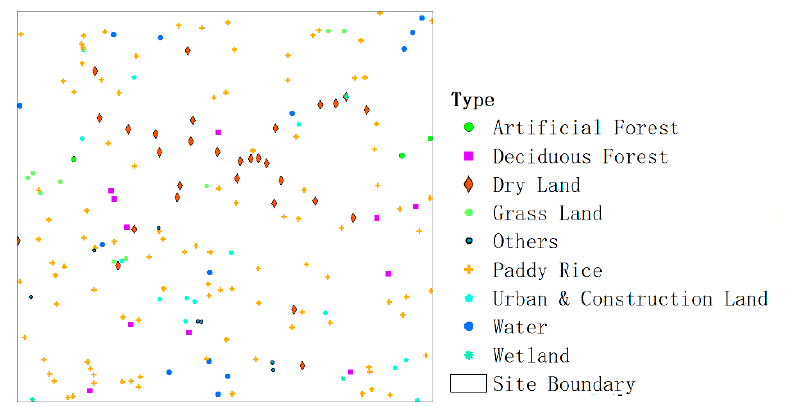
Figure 4. Sample points for nearest neighbor (NN) classifier.